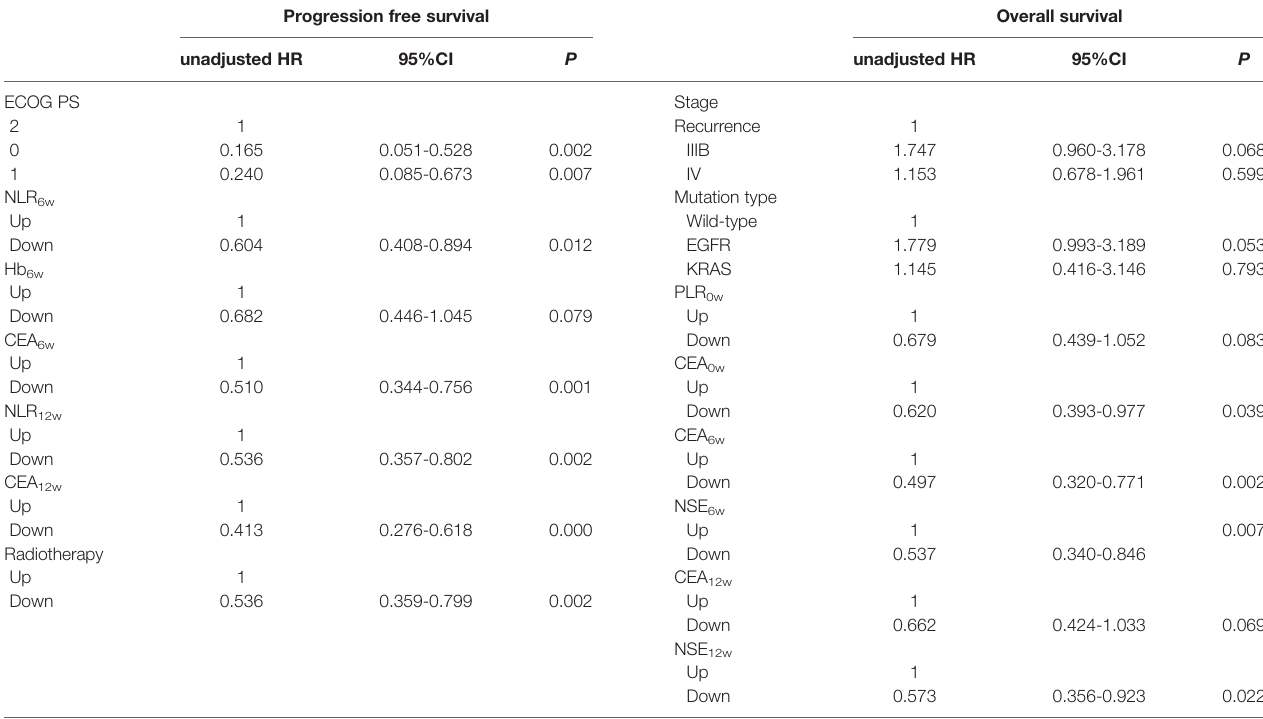
TABLE 4 | Univariable Cox regression analysis for PFS and